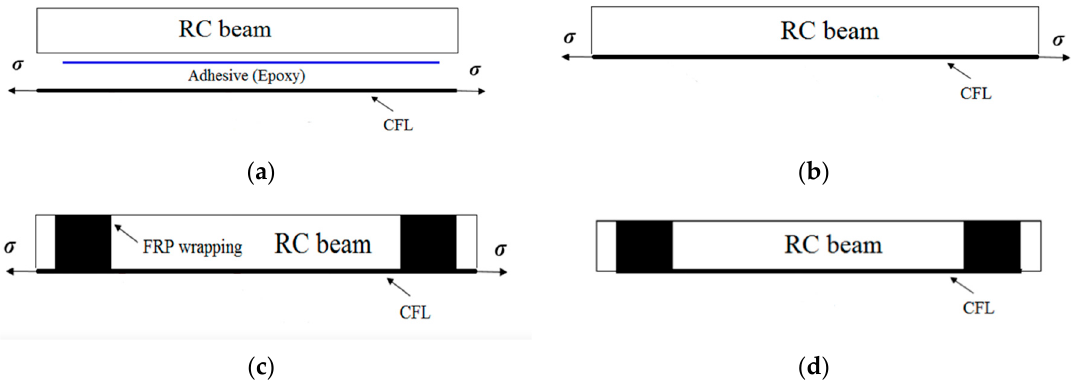
Figure 6. Strengthening method with prestressed CFL for RC beams. ( a ) Tensioning; ( b ) Bonding; ( c ) Curing; ( d ) Releasing.